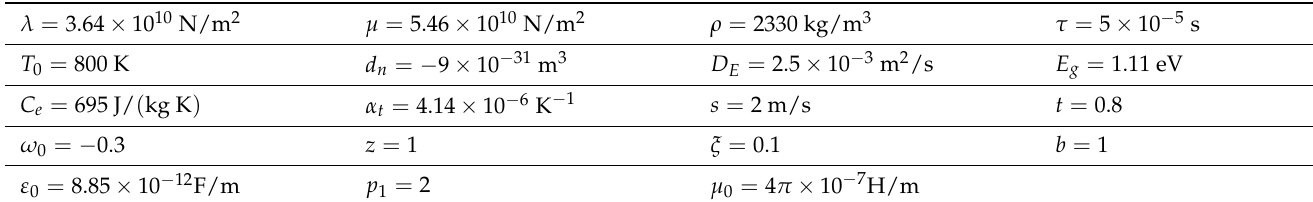
Table 1. The physical constants of Si